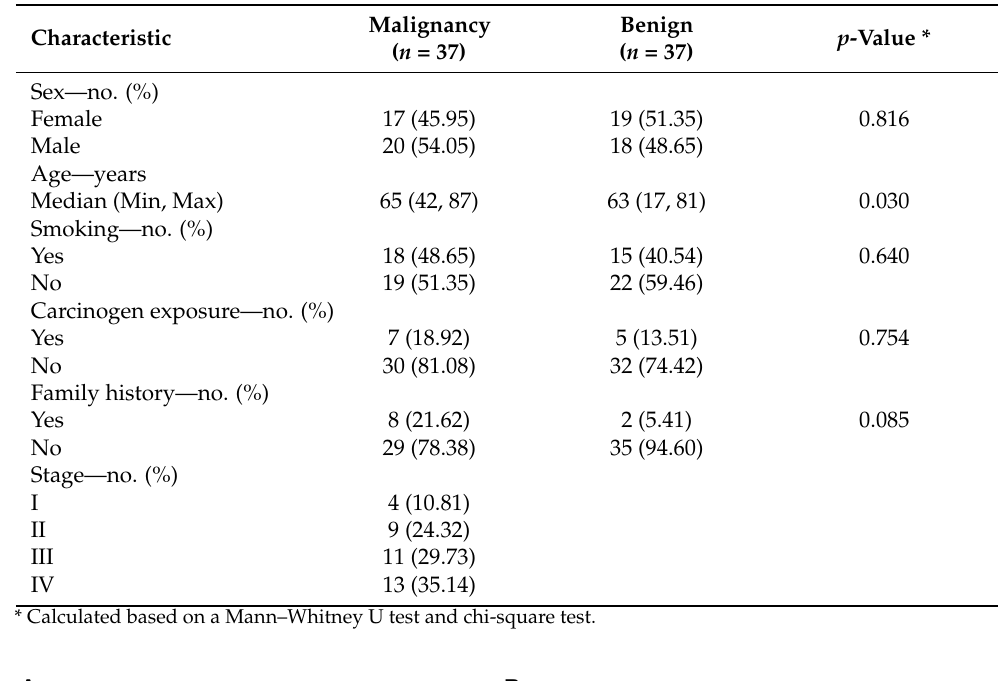
Table 2. Clinical characteristics of patients for clinical validation.